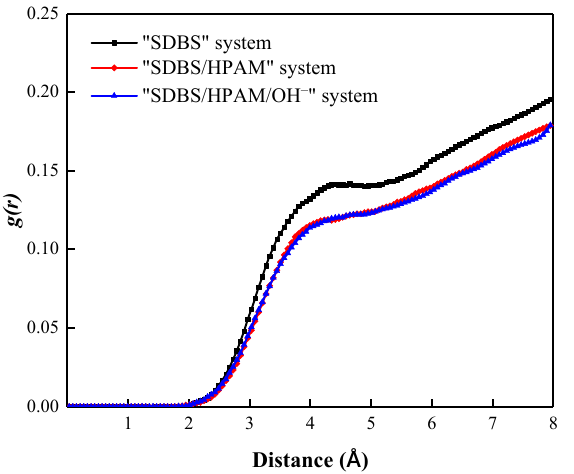
Figure 4. Snapshots of the different foam systems after the relaxation equilibrium.